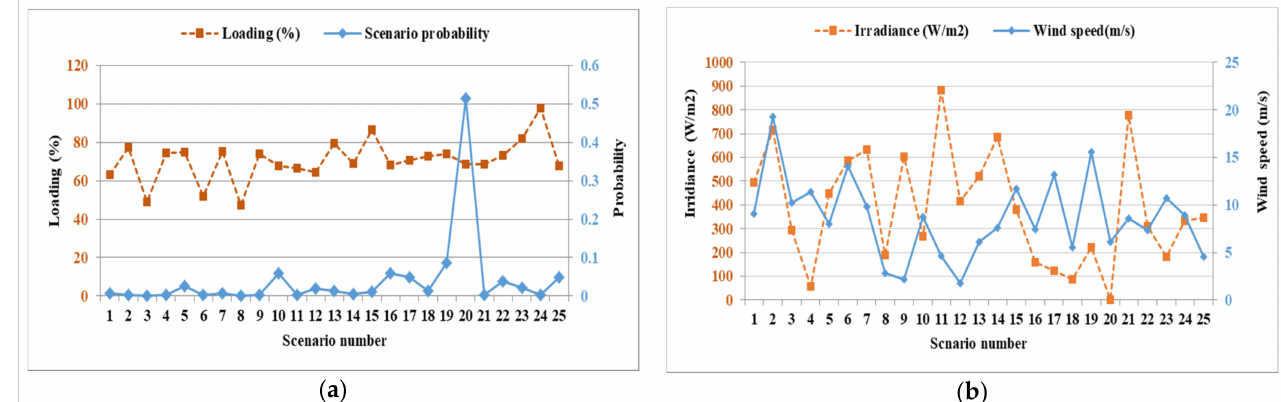
Figure 5. Clustered scenarios: ( a ) loading percentages and probabilities, ( b ) wind speed and solar irradiances.